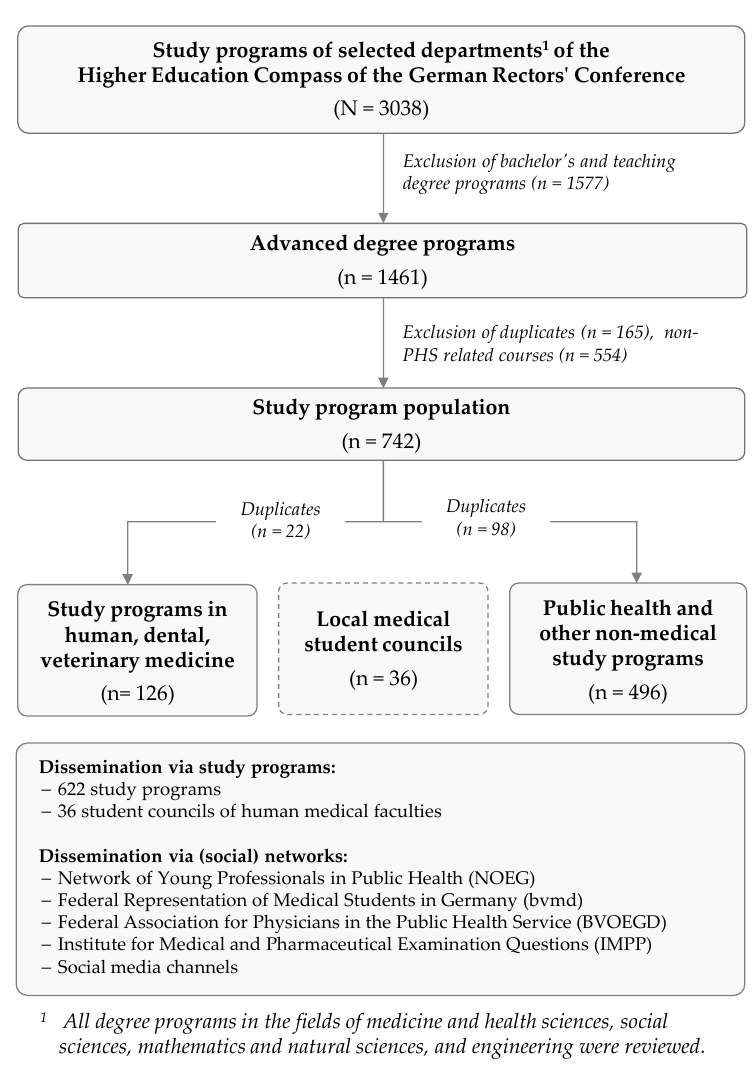
Figure 2. Flowchart for obtaining the distribution list to generate the OeGD-Studisurvey sample.